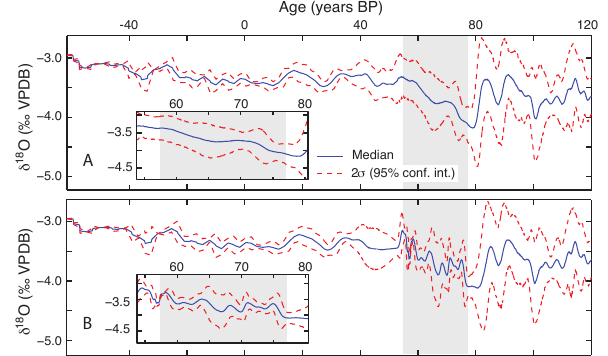
Fig. 11. YOK-G proxy record without and with layer count infor- mation: (A) the median proxy record (using 2000 MC simulations) for YOK-G (in blue) with 95% confidence bounds (in red) with- out incorporating the layer counted interval. Inset : a detailed view of the age model around the layer counted interval. (B) as (A) , but with incorporation of the layer counted interval. Inset : detailed view of the age model covering the layer counted interval. The proxy record in (B) is able to capture higher frequency variations in this layer counted interval that is not resolved in the proxy record in (A) due to the absence of layer counted age information.The confidence bounds were constructed similarly as in Fig.